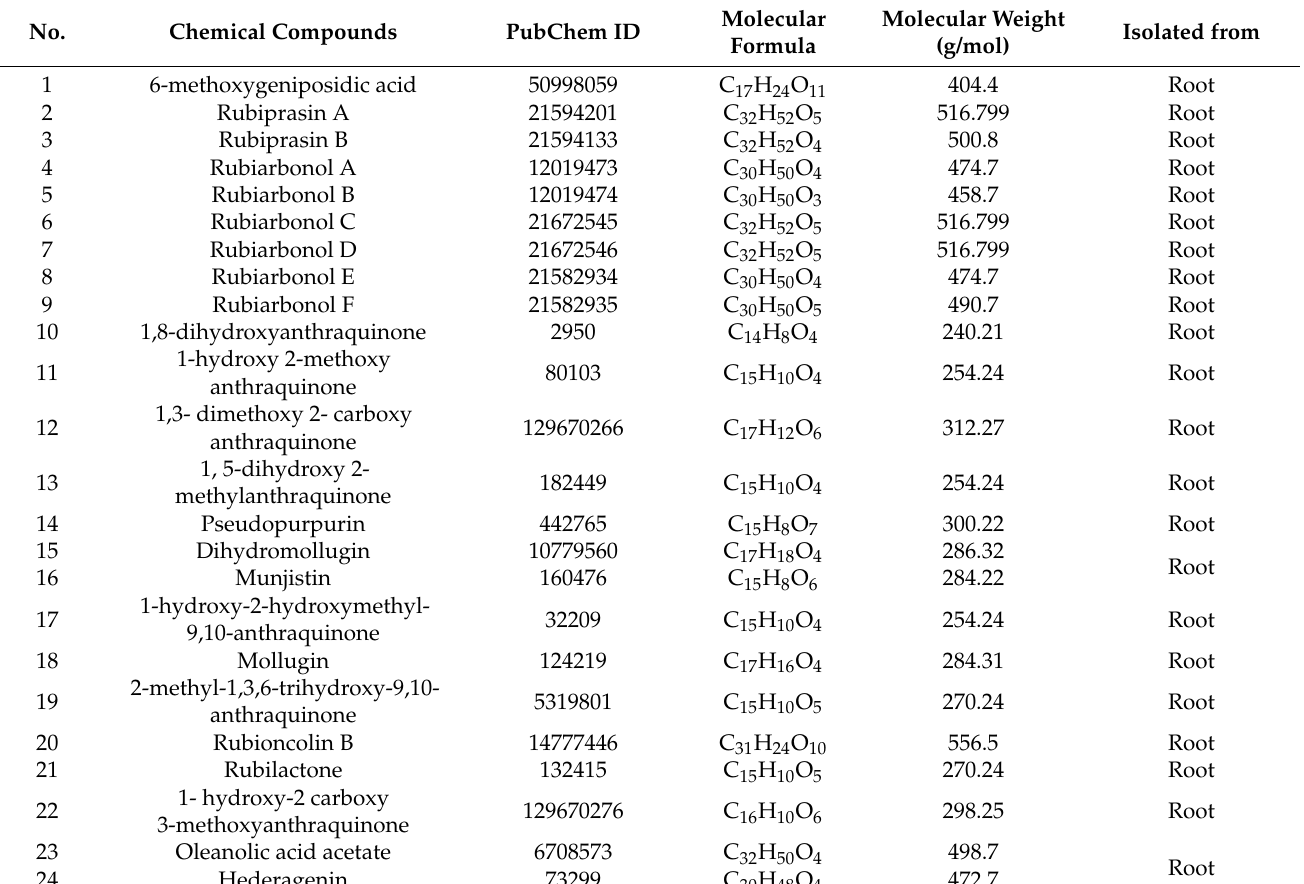
Table 1. Selected compounds identified from R. cordifolia